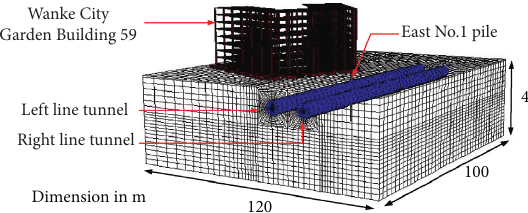
Figure 6: Three-dimension numerical